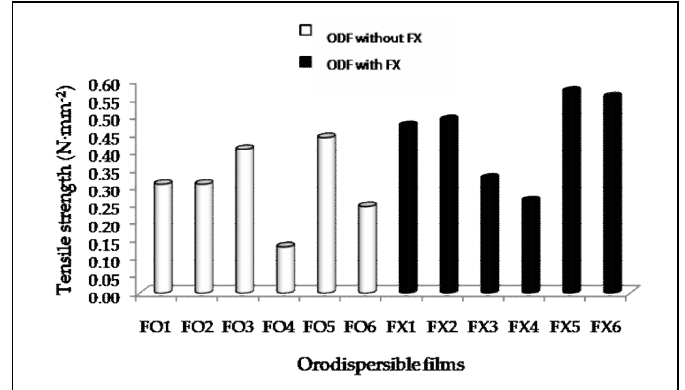
Figure 4. Tensile strength of the orodispersible films.